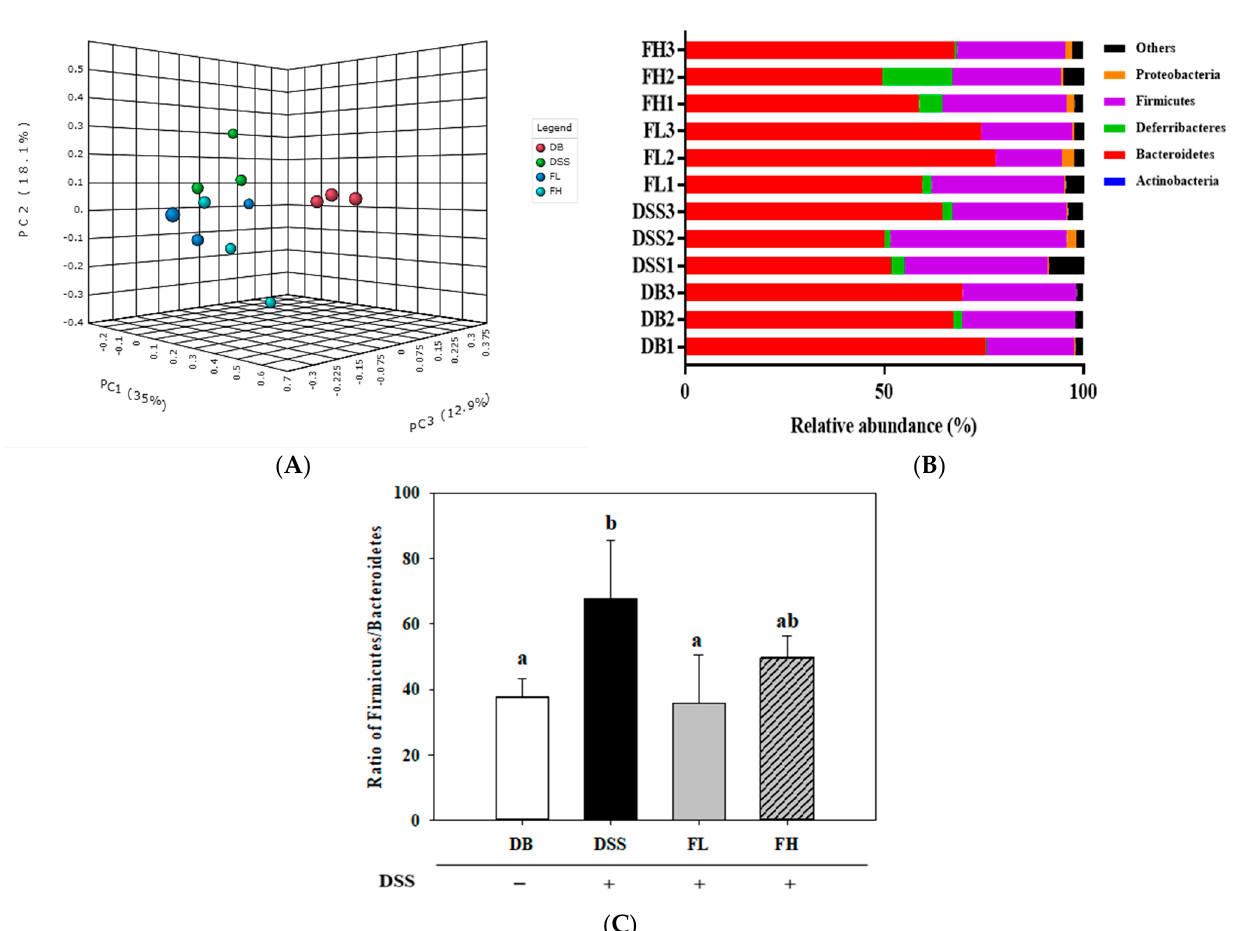
Figure 5. FMRP modulates the gut microbiota composition in colitis induced in the DB/DB mice. ( A ) The 3D principal coordinate analysis (PCoA) plots unweighted UniFrac based on operational taxonomic unit (out) level followed with permutational multivariate analysis of variance (PERMANOVA). ( B ) Relative abundance plot of the bacterial phylum level. ( C ) The ratio of Firmicutes to Bacteroidetes . DSS +/- indicates whether 2% DSS is treated or not. Different letters (a–b) denote a significant difference at p < 0.05 calculated using one-way ANOVA with Tukey’s multiple comparison test. Data of three cages per group are expressed as means ± SD. Three cages with 9 mice were included per group.